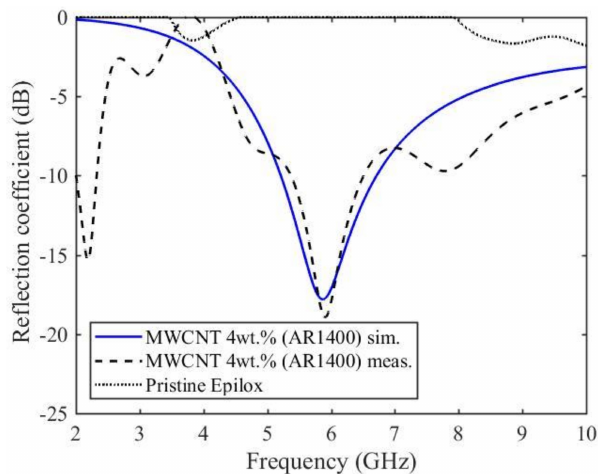
Figure 8. Microwaves reflection coefficient measurements: bare Epilox (dotted line) and 4 wt% MWCNT-loaded resin (dashed line). A comparison between the simulated (solid line) and the measured (black) reflection coefficient for the sample containing the carbon nanotubes is